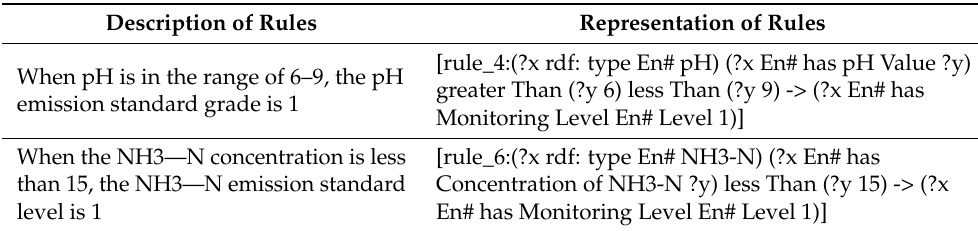
Table 4. Examples of Jena reasoning